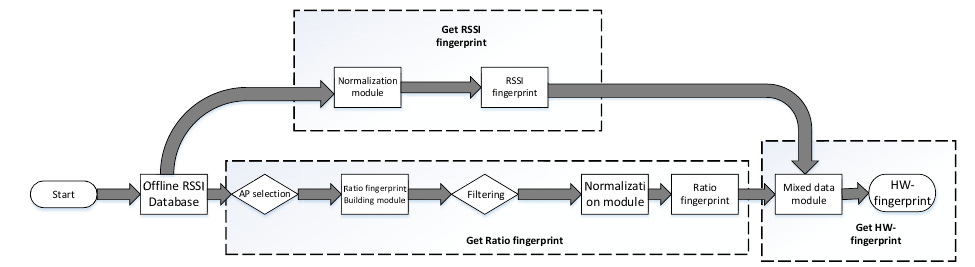
Figure 3. Flowchart of building Hybrid Wireless